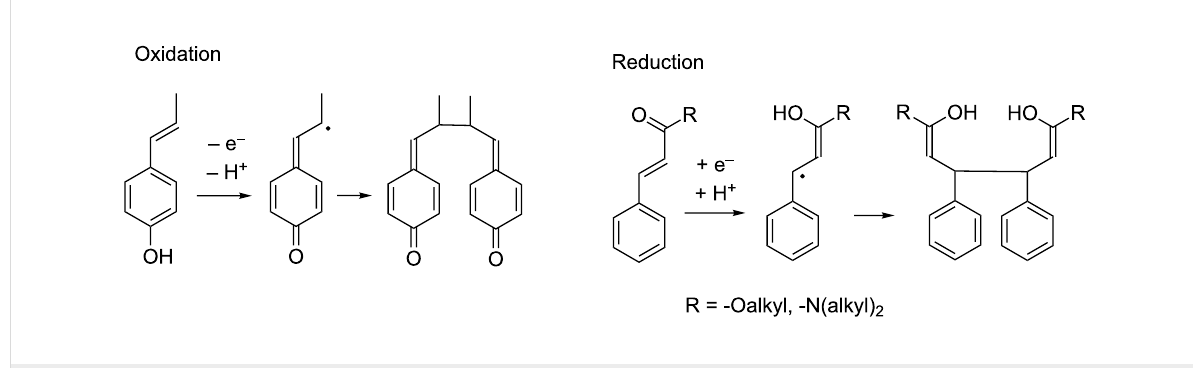
Figure 1: Expected coupling products from one-electron oxidation (left) and one-electron reduction (right) of C 6 –C 3